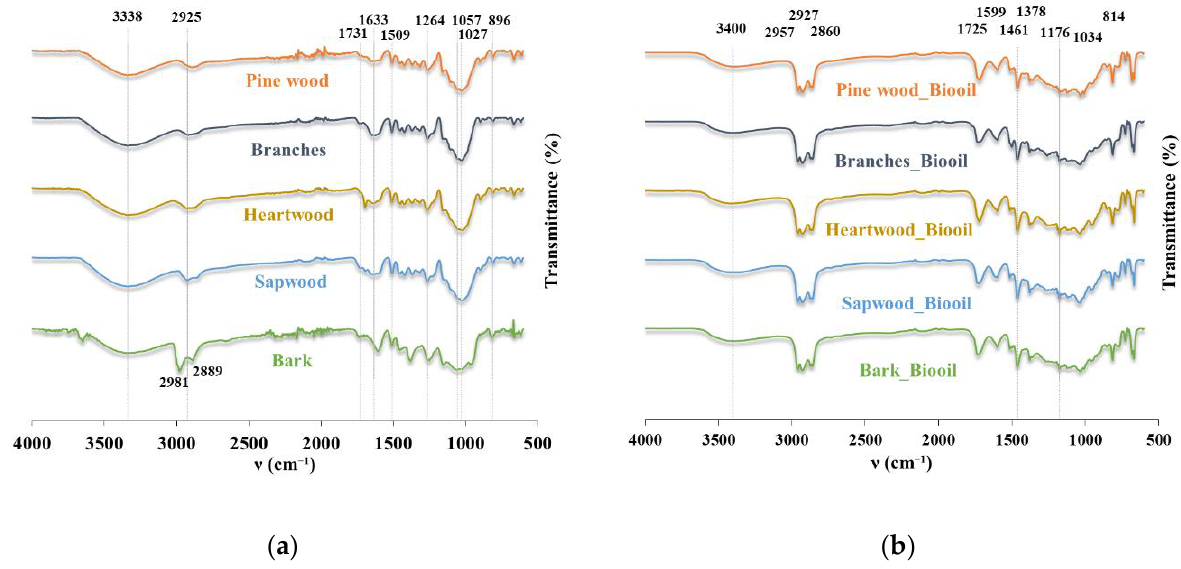
Figure 4. FTIR-ATR spectra of ( a ) biomasses obtained from Leiria National Park; ( b ) bio-oils from different feedstocks.